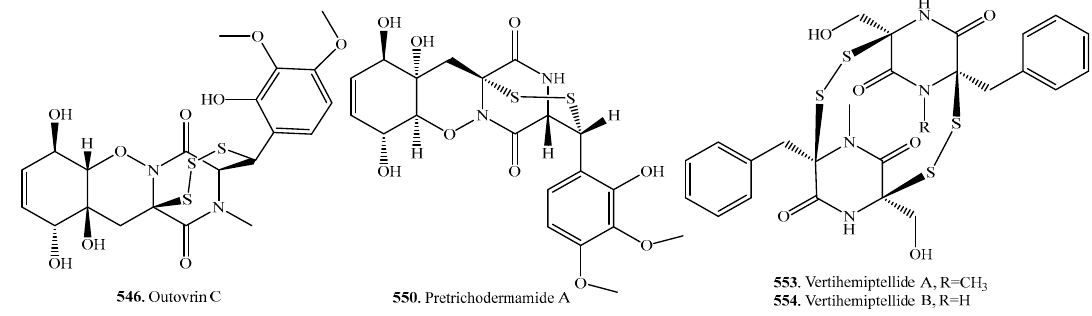
Figure 7. Structures of the analogs with sulfur-bridge outside 2,5-DKP ring isolated from fungi.